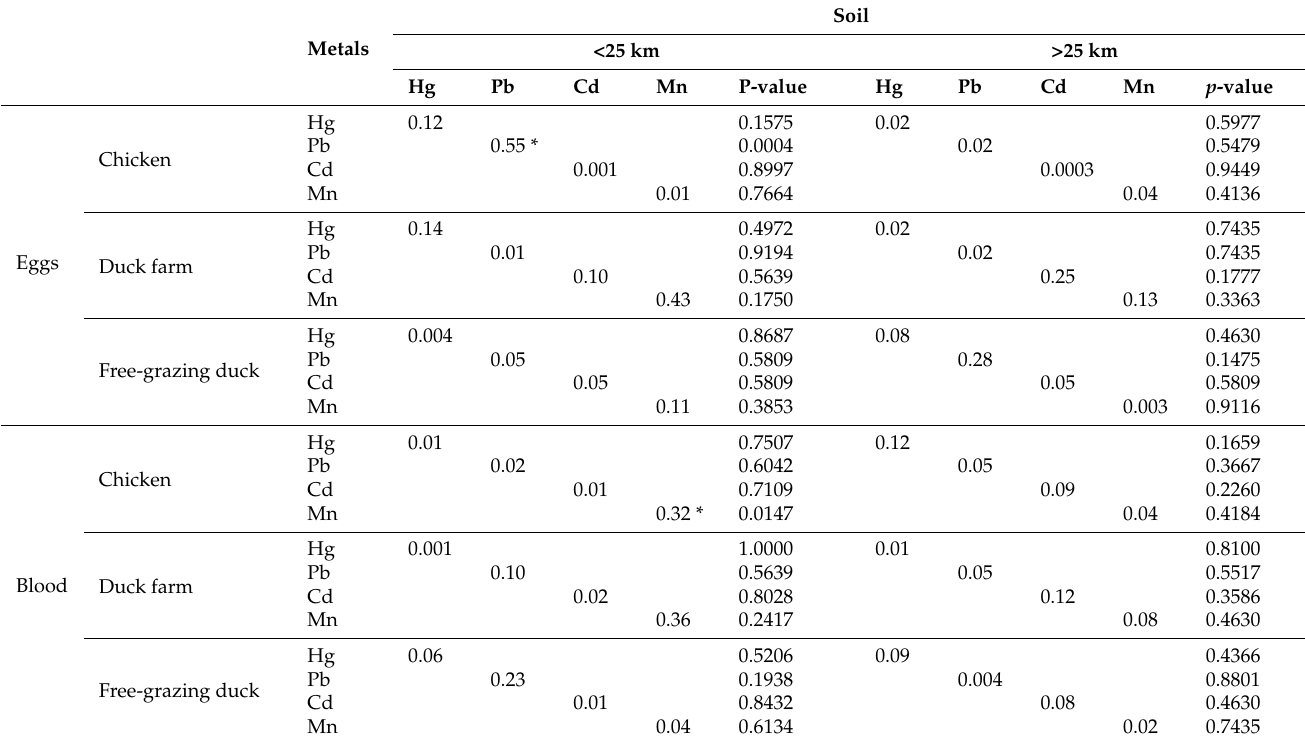
Table 7. Correlations between Hg, Pb, Cd, and Mn in eggs, blood, and soil (r 2